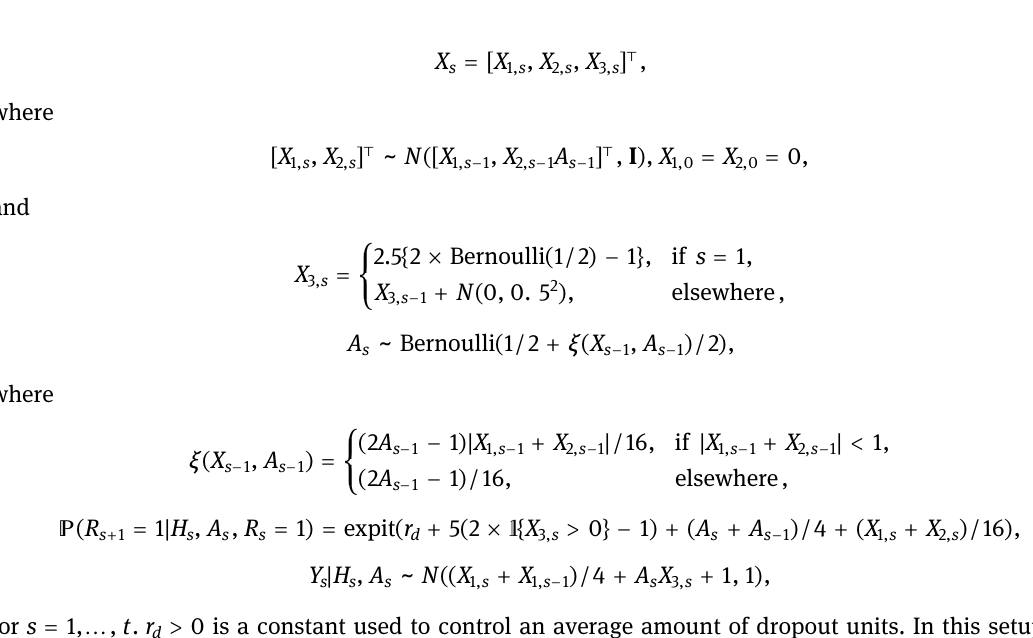
Figure 2: Variance ratio over t for the always - treated with δ 2, 5, 10 = ( Left ) , and for the never - treated with δ 0.5, 0.2, 0.1 = ( Right )